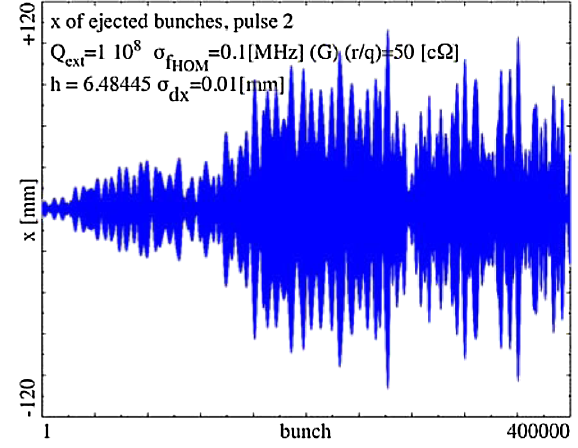
FIG. 50. (Color) x [mm] corresponding to Fig. 48. |V.t| after passage of bunch 400000, pulse 2